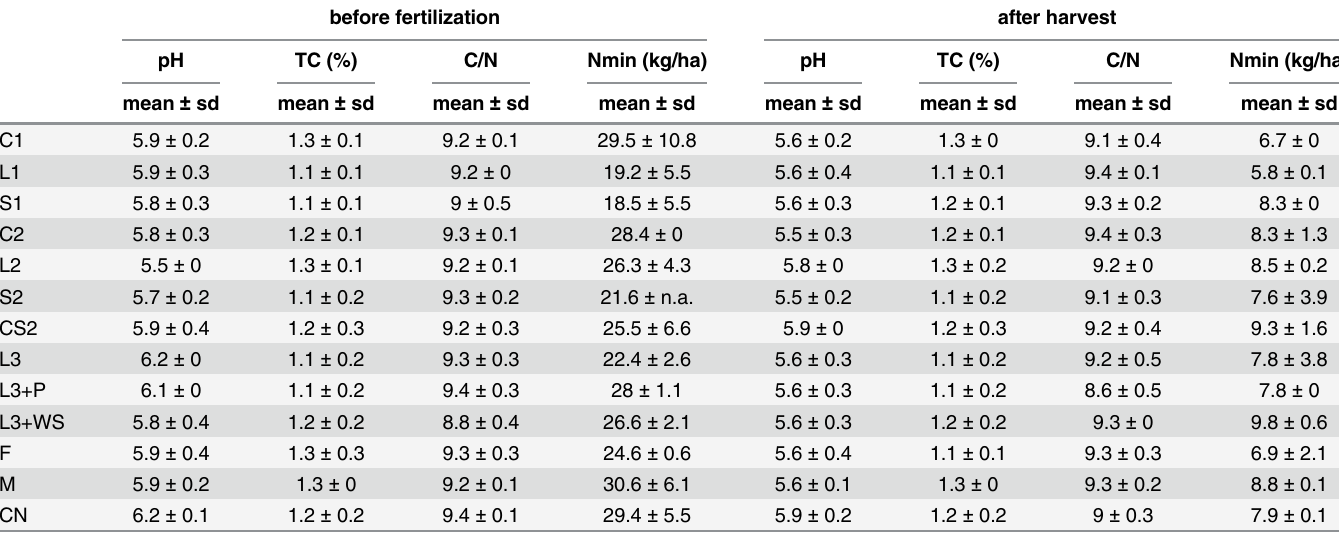
Table 2. Soil properties before fertilization and after harvesting. mean ± sd = mean value ± standard deviation, n.a. = sd is not possible, TC = total car- bon, TN = total nitrogen, N min = mineral